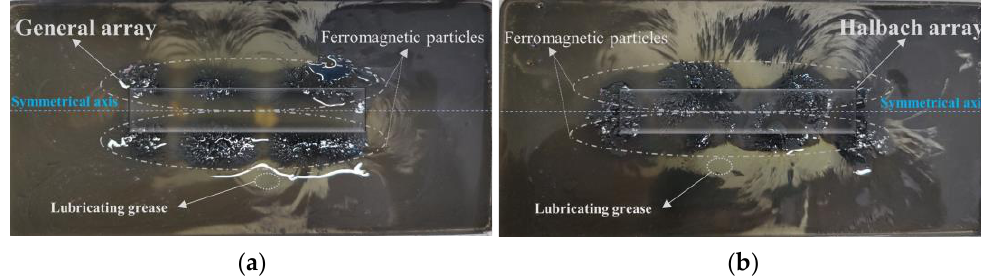
Figure 10. Comparison of the magnetic fields of different arrangements of permanent magnets. ( a )